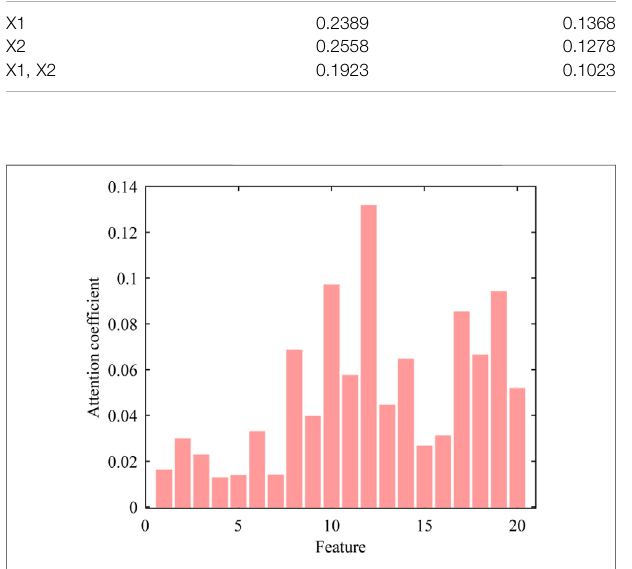
FIGURE 7 | Distribution of attention coef fi cient of the model.